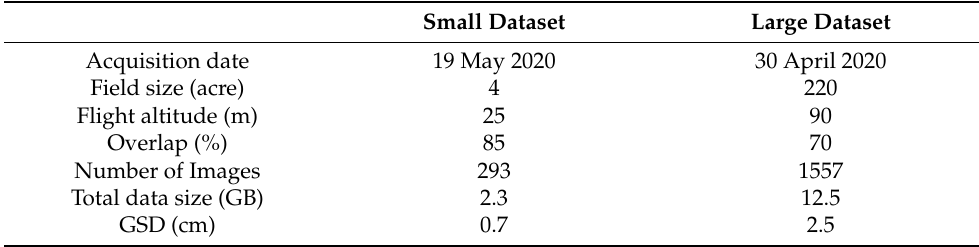
Table 1. Details of small and large